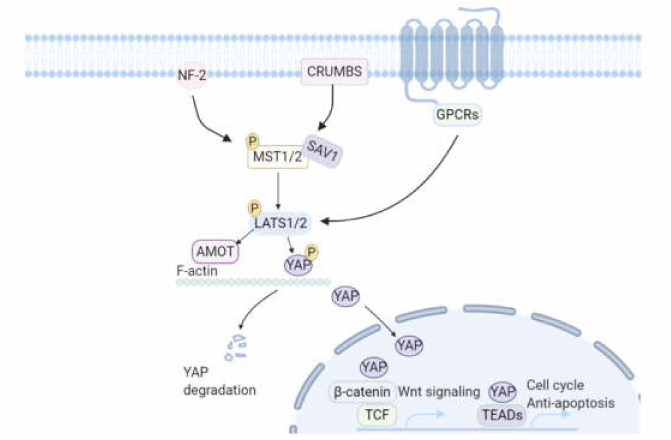
Figure 4. A simplified overview of the classic Hippo-YAP signaling pathway. The core of this Hippo-YAP is a cascade of kinase activation. When the Hippo pathway is activated by cell-cell contact, cytokine or mechanical stress, LATS1 / 2 and MST1 / 2 are recruited to the plasma membrane by NF-2 and sca ff old protein Salvador (Sav) respectively. MST then activates LATS by phosphorylation. Active LATS then phosphorylates YAP and its binding protein angiomotin protein (AMOT) to inhibit nuclear localization of YAP. Phosphorylated AMOT, bound to YAP, dissociates from F-actin and translocates to the cytoplasm, where the complex will be degraded via the ubiquitin–proteasome system. Upon inactivation, YAP is dephosphorylated and translocated to the nucleus, where it interacts with TEAD transcription factors to promote cell cycle and anti-apoptosis gene transcription. Nuclear YAP can also enhance Wnt / β -catenin signaling by binding to b-Catenin / TCF transcription activation complex. NF-2: Neurofibromin 2; YAP: yes-associated protein 1; LATS1 / 2: Large tumor